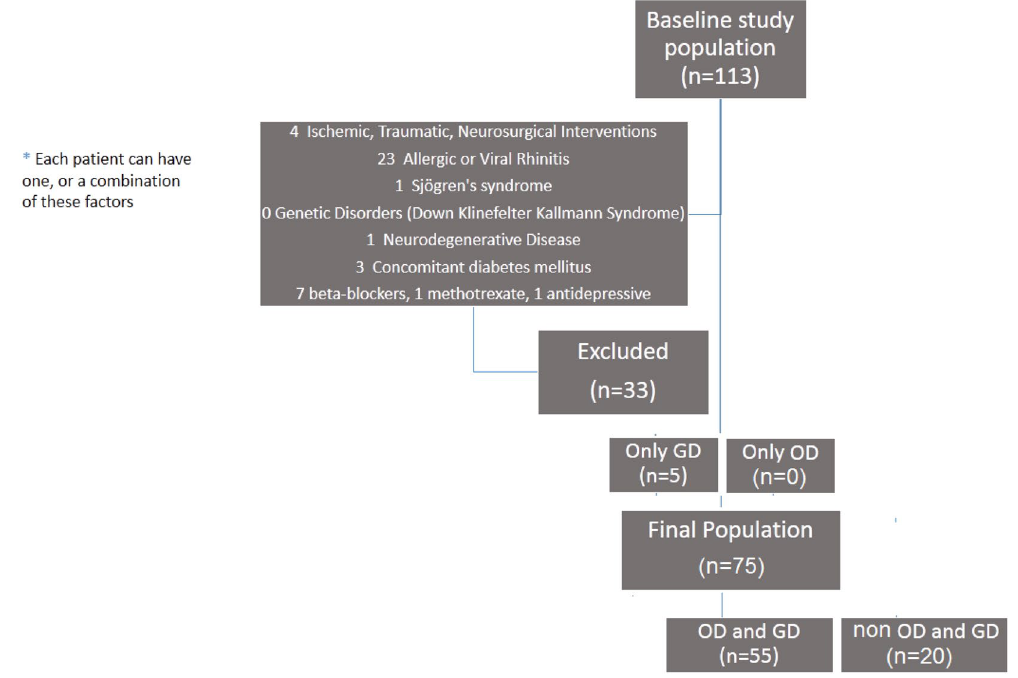
Figure 1. Patients included after the screening based on exclusion